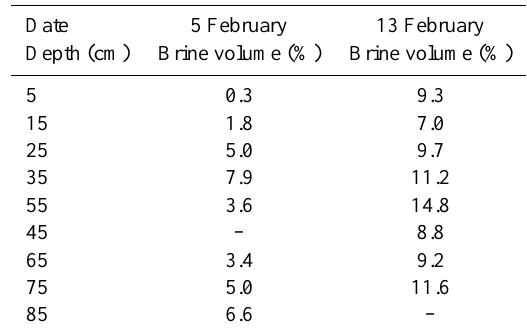
Table 4. Brine volumes in the cores of Fig.